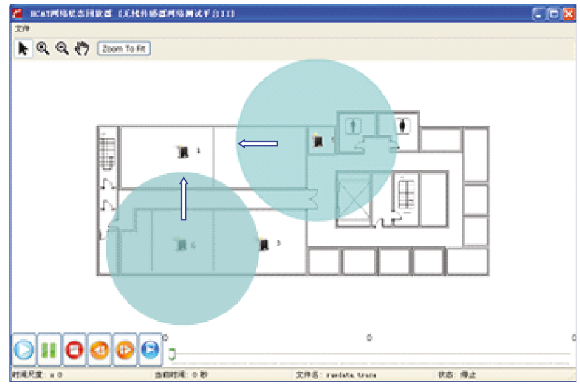
Figure 21: Animation of the network behavior history.